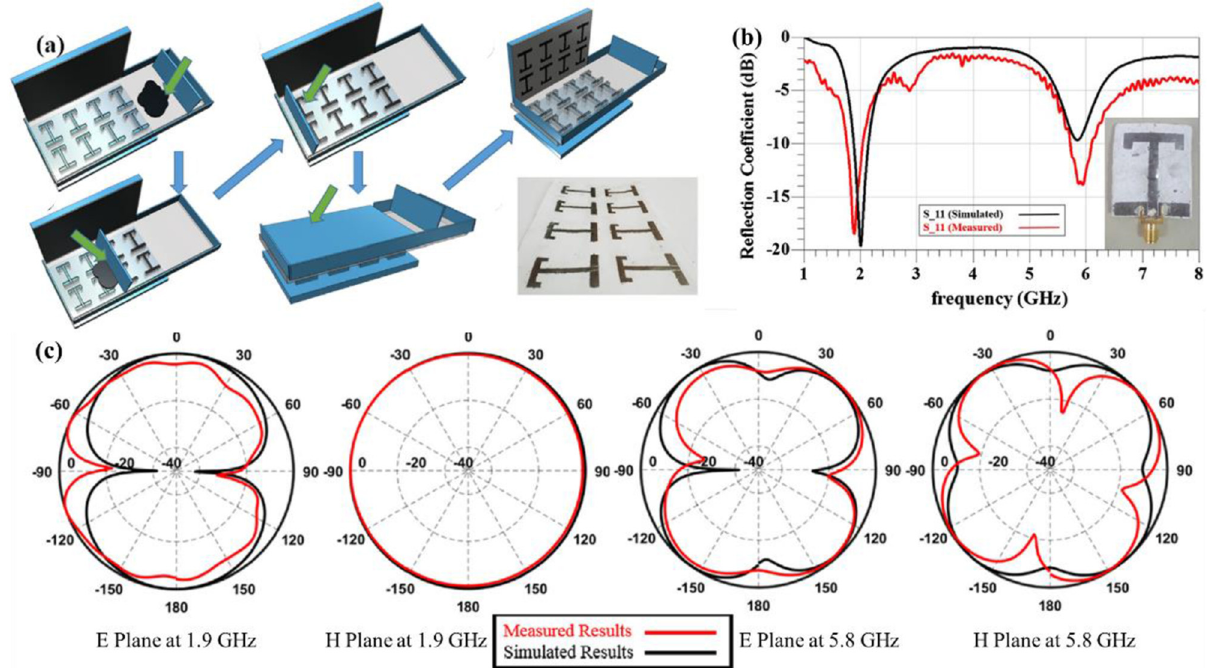
Fig. 11. (a) Schematic diagram for the printing steps of the paper-based antenna. (b) The simulated/measured re fl ection coef fi cient of the printed EG antenna. (c) The normalized simulated versus measured radiation pattern in the two planes at 1.9 and 5.8 GHz [112]. Reproduced with permission from A.A. Abdel Aziz et al., Int. J. Electron. Commun. 110 , 152869 (2019). Copyright 2019